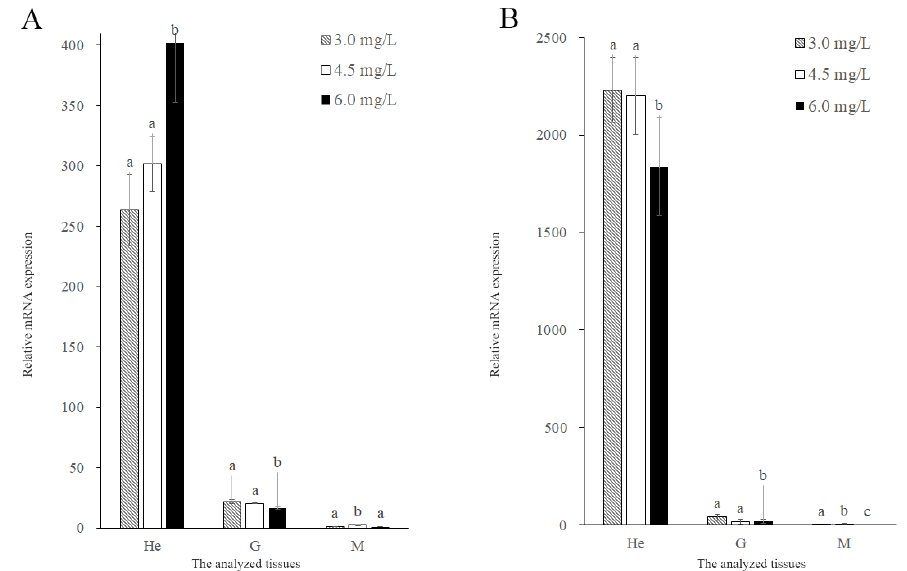
Figure 7. Expression of MnGST-1 ( A ) and MnGST-2 ( B ) in the hepatopancreas (He), gill (G) and muscle (M) of M. nipponense in response to chronic hypoxia stress experiment. Values are means ± SE for triplicate samples. Bars with different letters indicate significant differences ( p < 0.05).